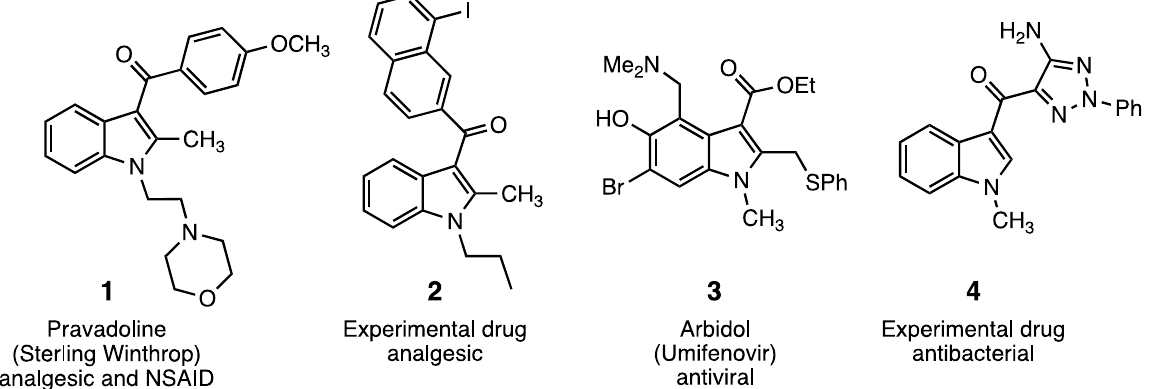
Figure 1. Indole-containing drug compounds incorporating the N -alkyl and 3-acyl groups.